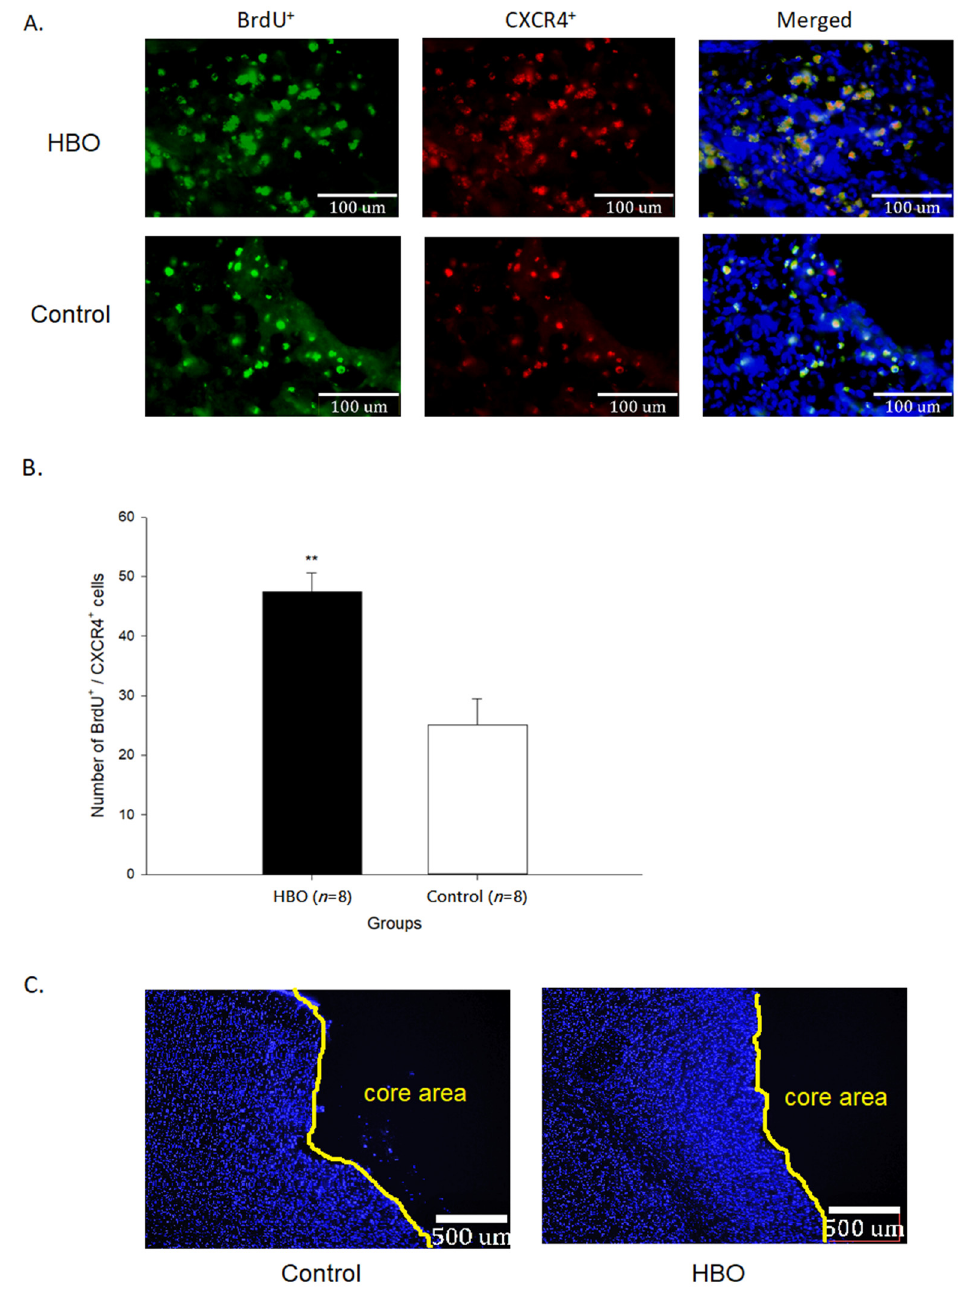
Figure 4. ( A ) The immunofluorescence imaging of BrdU + (green) and CXCR4 + (red) cells in the penumbra area between groups (under 40 × objective lens). ( B ) The quantifications of BrdU + /CXCR4 + cells in the penumbra area between groups. ( C ) Illustration of penumbra and core area boundaries (under 5 × objective lens). Nuclei stained with DAPI (blue). **, p < 0.01. HBO: hyperbaric oxygen; CXCR4: CXC chemokine receptor 4.